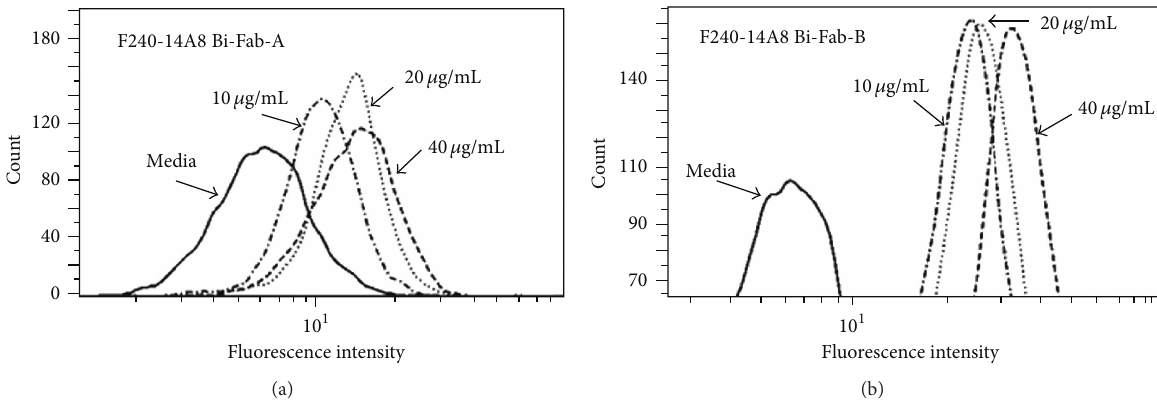
Figure 3: Binding affinity of F240 × 14A8 Bi-Fab with neutrophil through CD89. Neutrophils were washed twice with PBS and resuspended at a concentration of 1 × 10 7 c/mL in HBSS containing 2.5% FBS. 100 𝜇 L of neutrophils was mixed with 100 𝜇 L of serial diluted Bi-Fab antibodies with Bi-Fab A in (a) and Bi-Fab B in (b). Cells were incubated with FITC-labeled goat anti-human Ig Kappa for 30 minutes. Neutrophils were fixed in 1% paraformaldehyde. Results are representative of four different neutrophil donors.